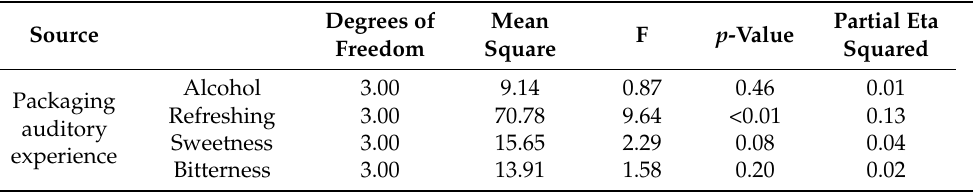
Table 4. Summary of the results of the univariate tests of Experiment 1 at the between-participants level (packaging auditory experience condition) on each sensory score.